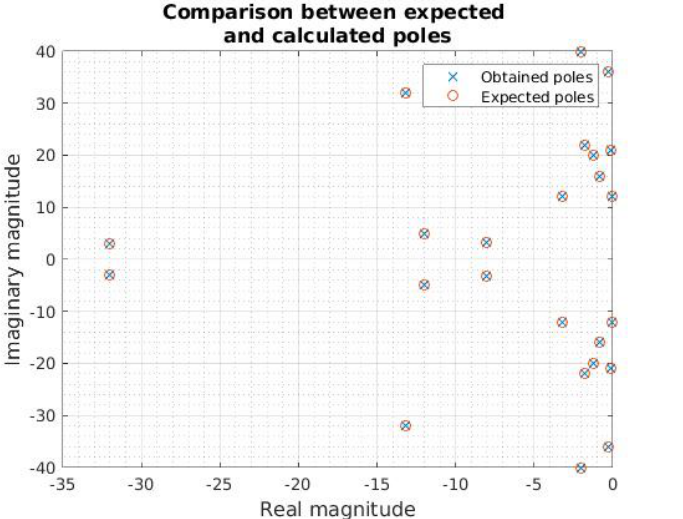
Figure 3. Comparison between expected poles and obtained poles in the signal